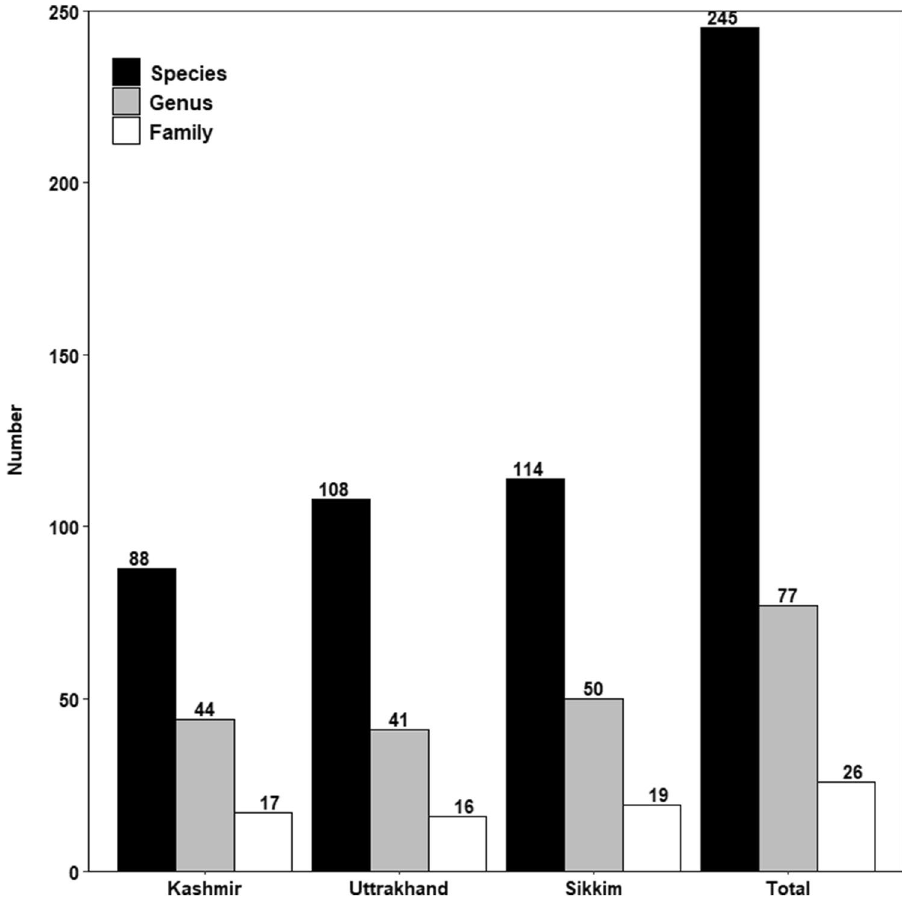
Figure 3. Taxonomic conspectus of macrolichens in Kashmir, Uttarakhand and Sikkim Himalaya.